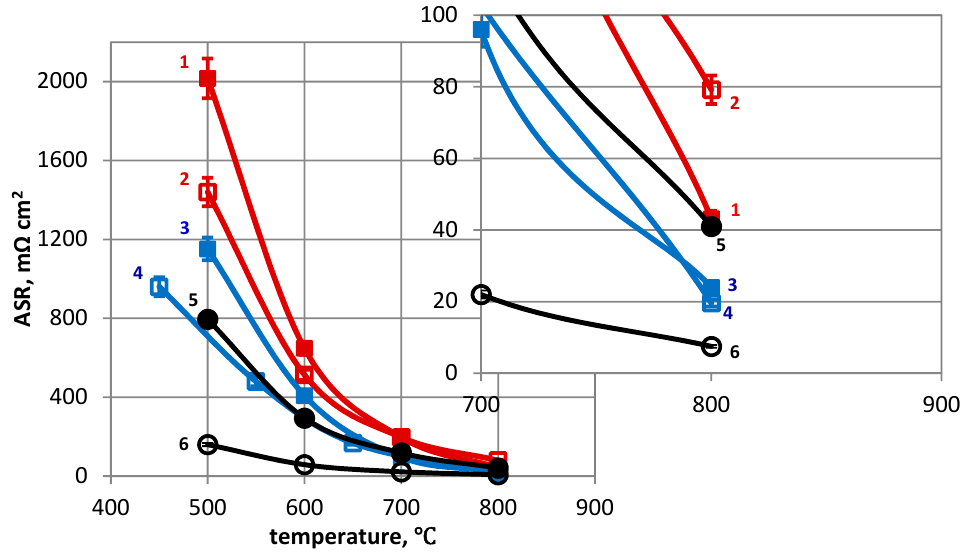
Figure 8. ASR of oxide coatings with the temperature range of 500–800 °C. 1 and 2 : Co-40Mn coating oxidized at 750 °C in air for 100 h and 20 h; 3 and 4 : Co-38Mn-2La coating oxidized at 750 °C in air for 100 h and 20 h; 5 and 6 : Co-33Mn-17Cu coating oxidized at 750 °C in air for 100 h and 20 h.